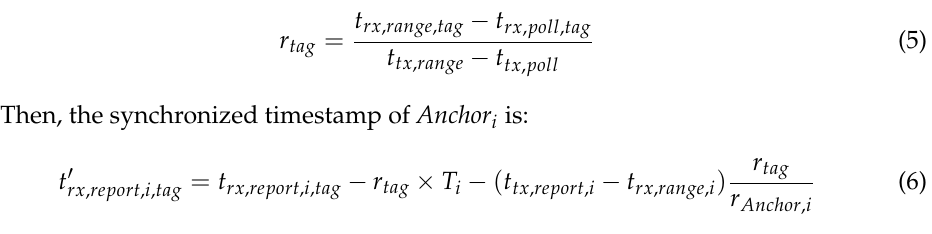
Figure 4. The hyperbolas may intersect in a region instead of a point. The position of a Tag needs to be estimated.